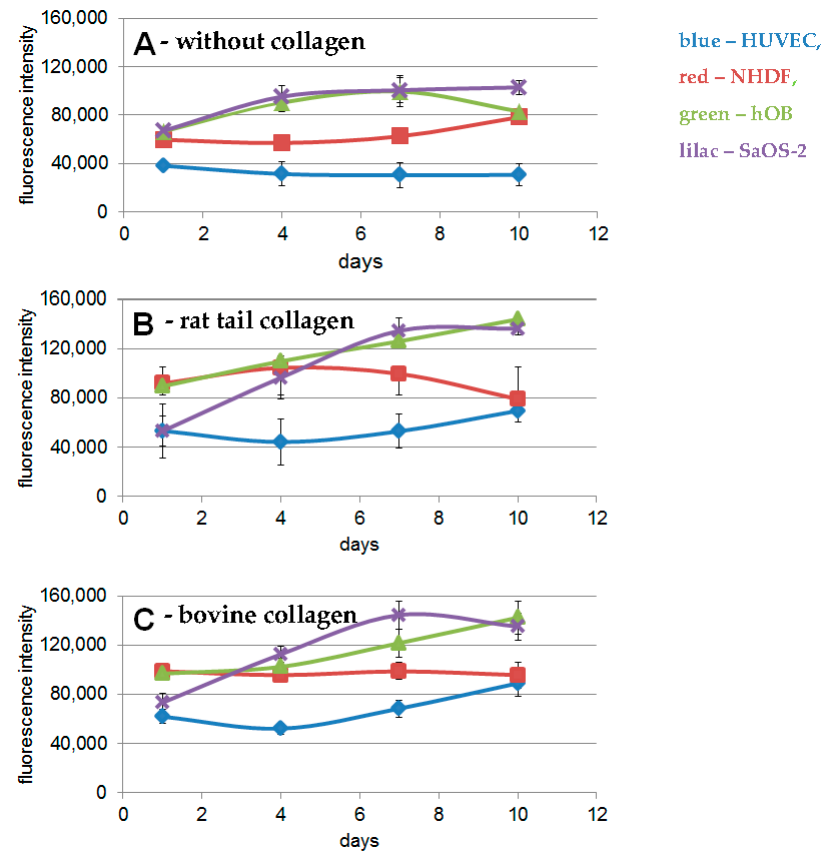
Figure 5. Proliferation assays on PLA discs with different cell types. ( A ) without collagen, ( B ) PLA discs coated with rat tail collagen, ( C ) PLA discs coated with bovine collagen. Blue: HUVEC, red: NHDF, green: hOB and lilac: SaOS-2.